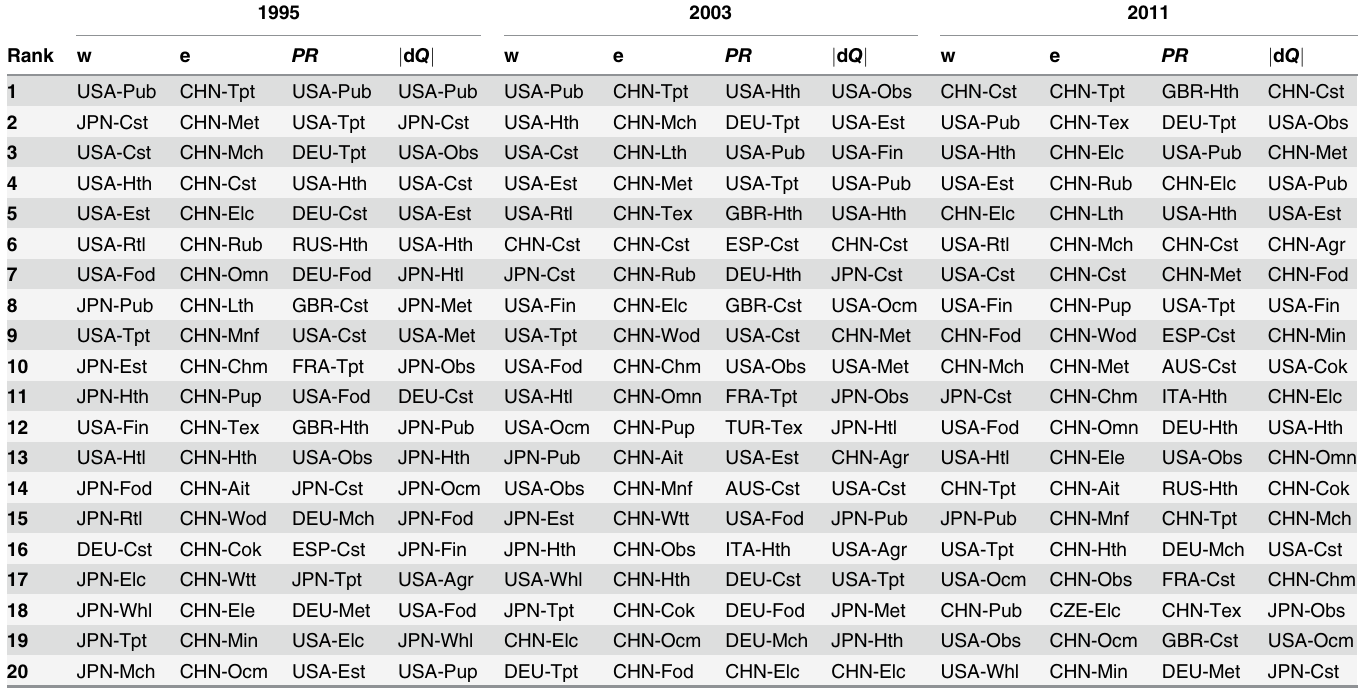
Table 2. Top 20 industries identified by the four methods for selected years. The first is the Laumas method of backward linkages, w . The second is the eigenvector method of backward linkages, e . The third is PageRank centrality, PR . The fourth is community coreness measure j d Q j